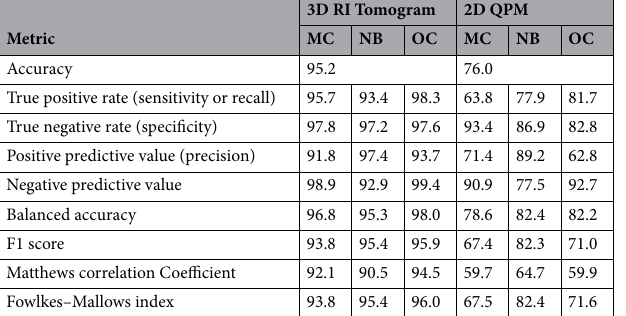
3D RI Tomogram 2D